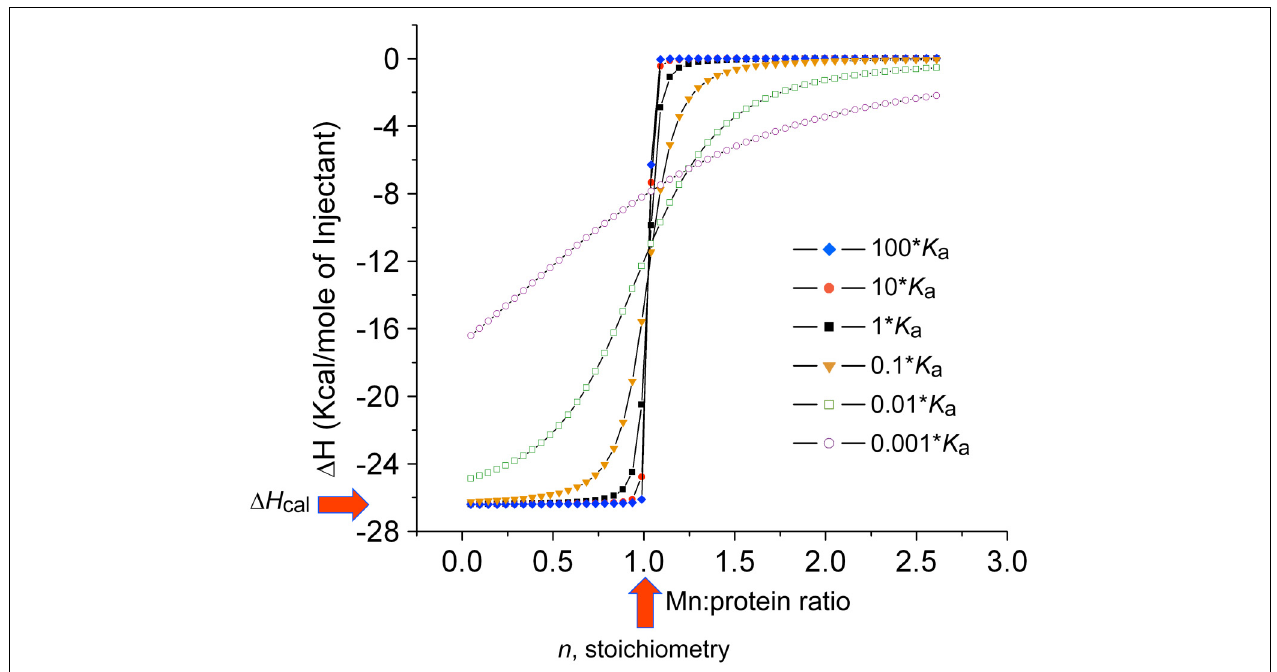
FIGURE 5 | Simulated binding curves for ITC thermograms using the reported thermodynamics and injection volumes of the MnCl 2 binding to the S (cid:2) 2 mutant of CP (Damo et al., 2013). The simulated curve that corresponds to the reported K d of 5.8nM (at 10 μ M total CP heterodimer), n = 1 . 0 ( red vertical arrow) and (cid:2) H cal = 26 . 2 kcal mol − 1 ( red horizontal arrow) was converted to K